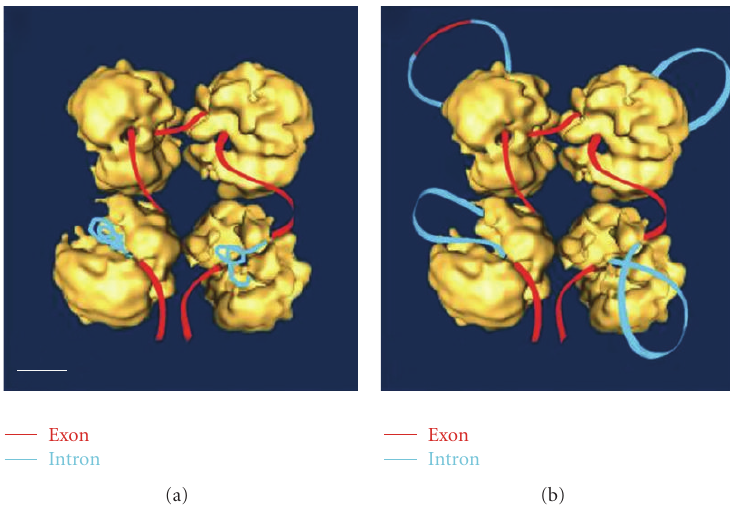
Figure 3: The supraspliceosome model from the article by Sperling et al. [8]. (a) It was stated that pre-mRNA which is not being processed is folded and protected within the native spliceosome. (b) With di ff erent staining protocol, it was possible to visualize the RNA strands and loops emanating from the supraspliceosome. These complexes were found to contain hnRNP proteins (personal communication).